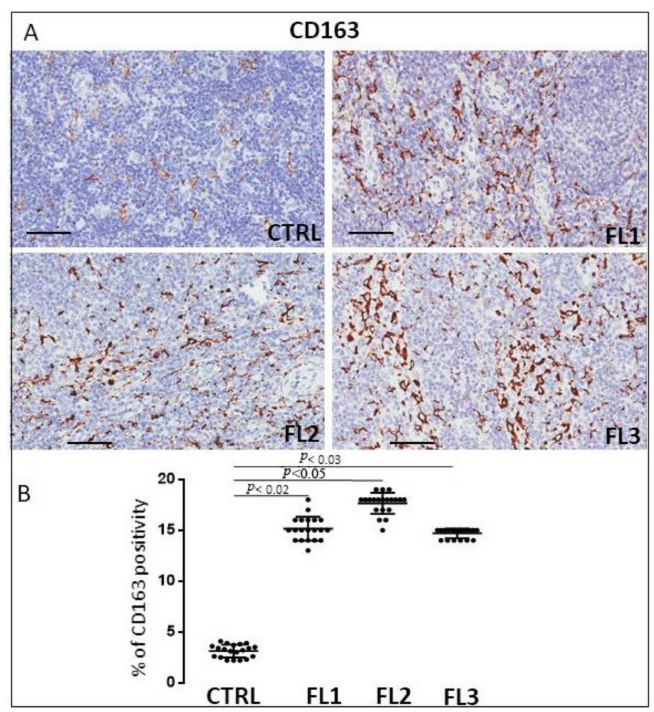
Figure 2. Immunohistochemical staining for CD163 in FL grade1 (FL1), FL grade2 (FL2), and FL grade 3 (FL3) and control samples (CTRL). Scale bar: 60 µ m ( A ). Morphometric analysis indicates the percentage of CD163 positivity in FL and CTRL samples ( B